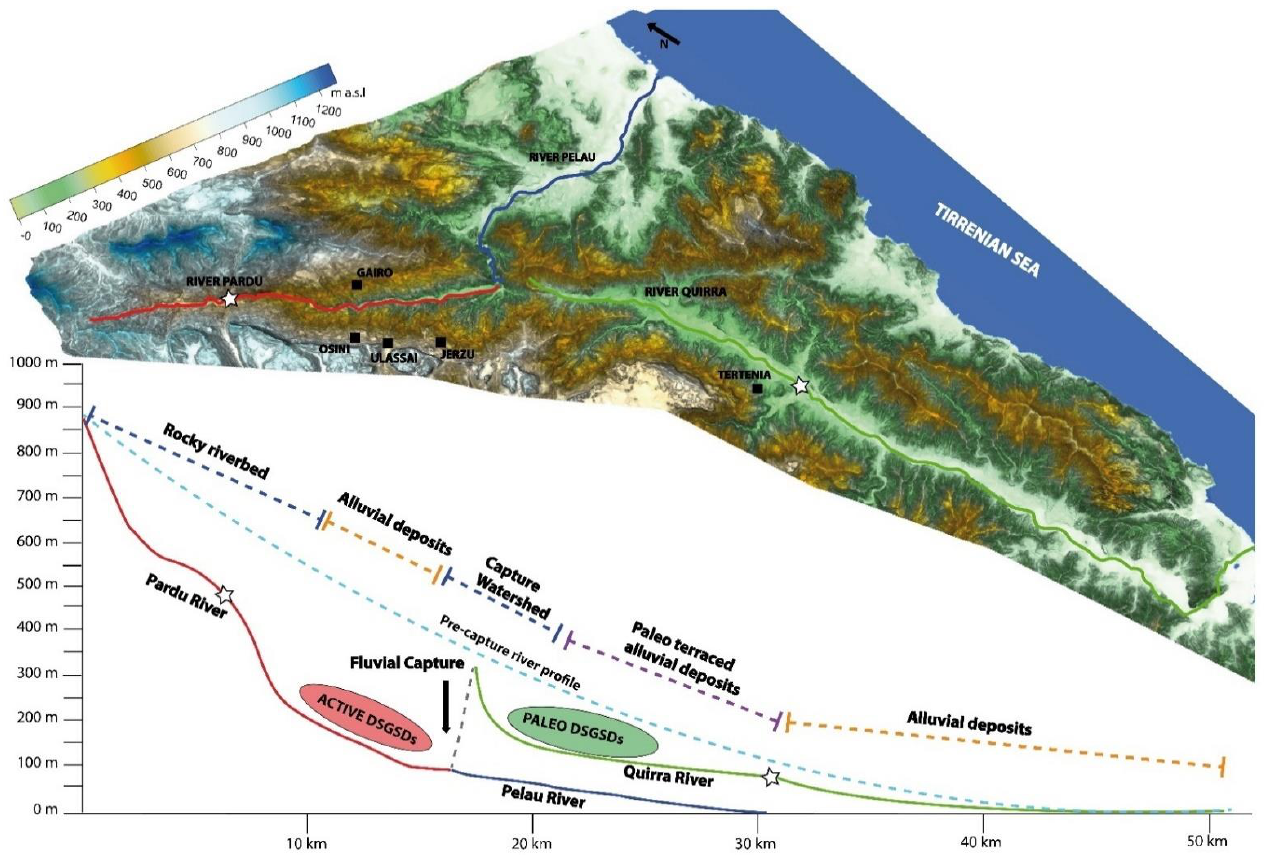
Figure 14. Relation between DGSD activity and river parameters. These DGSDs were associated with numerous large collateral rockfalls and toppling landslides that affected the slopes. Dolomitic blocks with sizes of up to 30 m on each side were identified; these moved up to 900 m away from the detachment points, which were linked to mega-rockfall events with rock avalanche features. We also identified